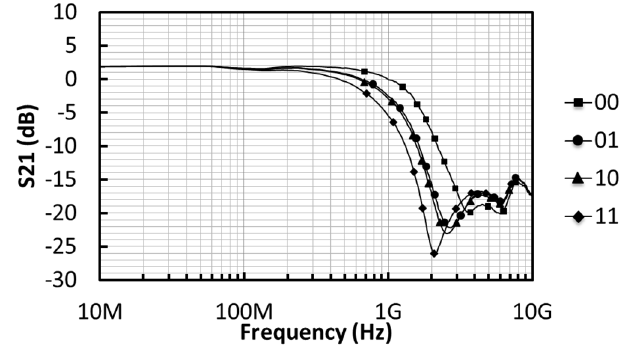
Figure 11. Measured S 21 of the first biquadratic filter.